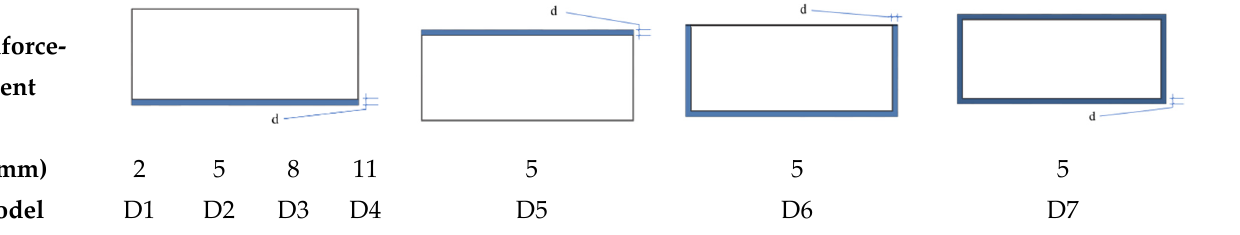
Figure 10. Anti ‐ blast simulation scheme. ( d is the thickness of polyurea) Figure 10. Anti-blast simulation scheme. ( d is the thickness of polyurea).